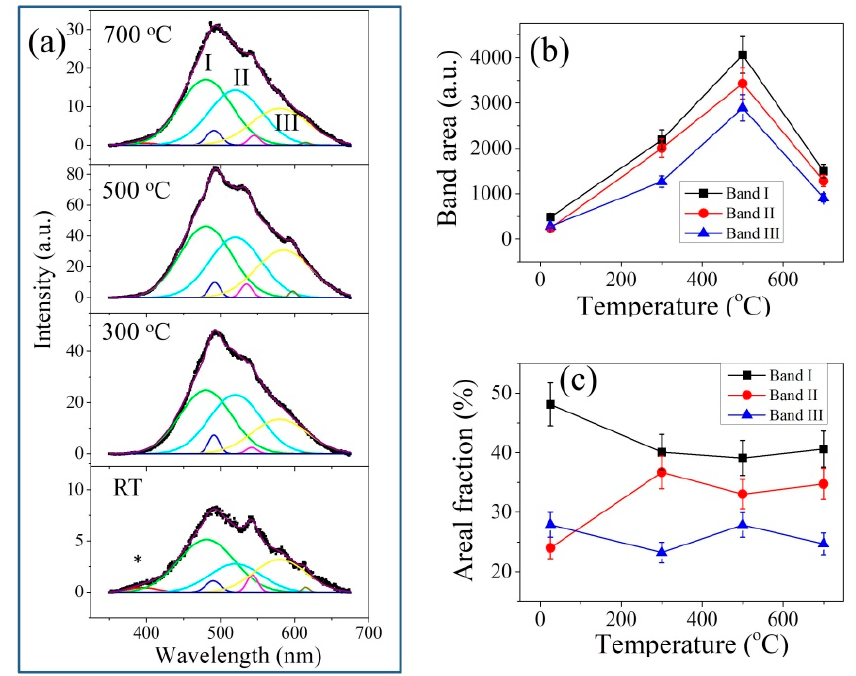
Figure 4. Variations of ( a ) CL spectra, ( b ) band area and ( c ) areal percent of the sub-bands with annealing temperature for the YSZ samples.